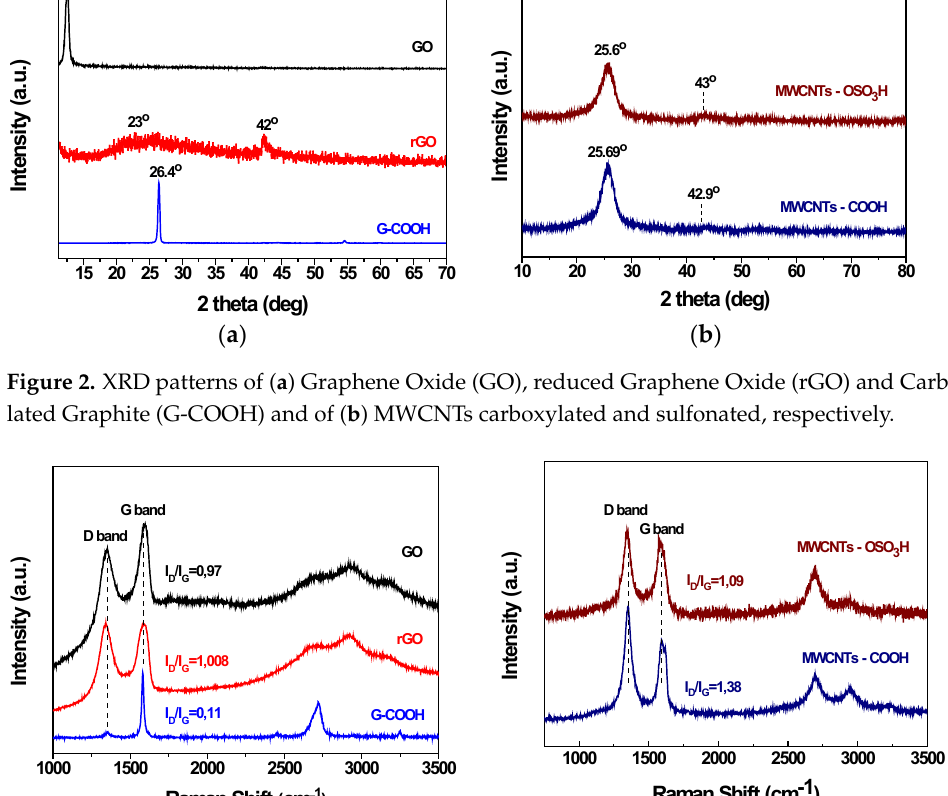
Figure 2. XRD patterns of ( a ) Graphene Oxide (GO), reduced Graphene Oxide (rGO) and Carbox- ylated Graphite (G-COOH) and of ( b ) MWCNTs carboxylated and sulfonated, respectively.